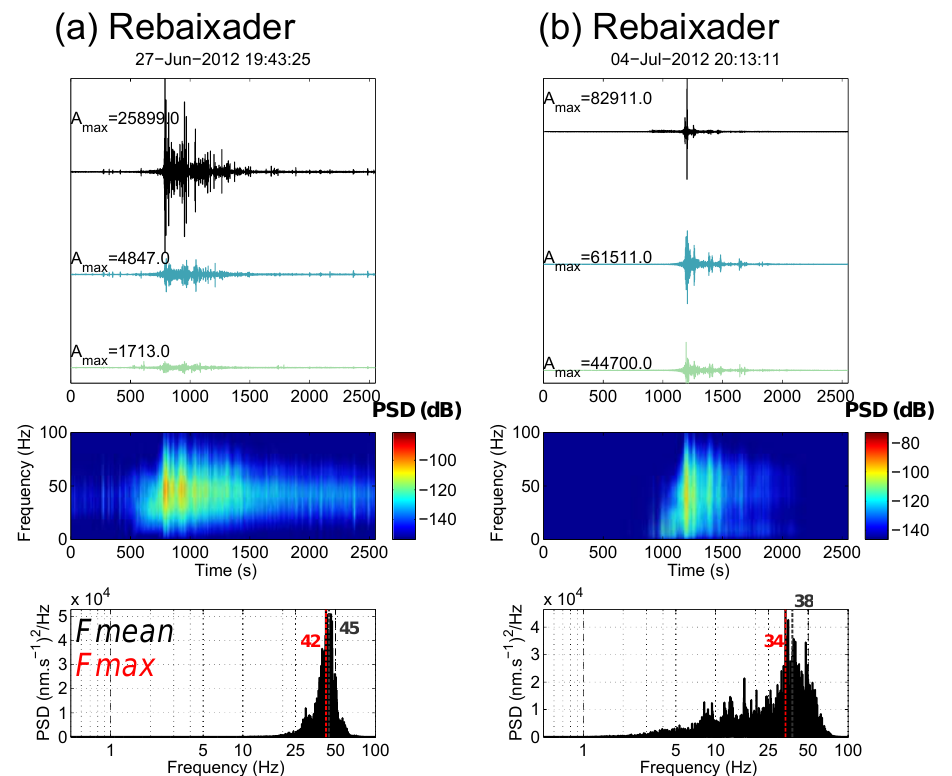
Figure 5. Wet granular flow events recorded at Rebaixader torrent (Abancó et al., 2012; Hürlimann et al., 2014; Arattano et al., 2016). See Fig. 2 for a description of the figure.